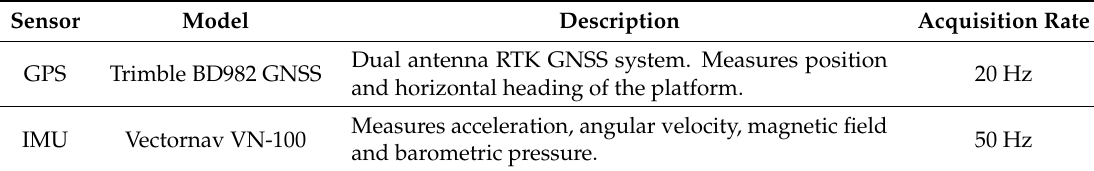
Table 3. Proprioceptive